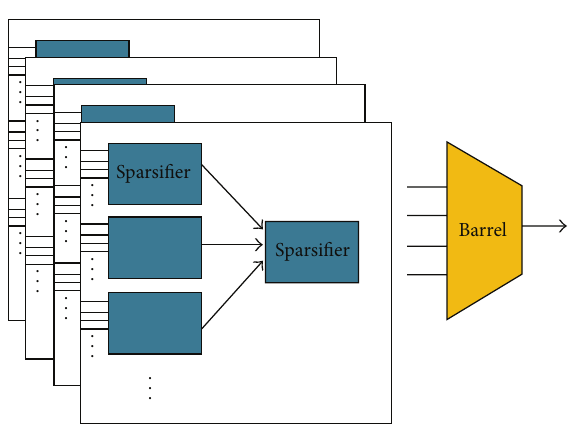
Figure 18: Sparsifiers and